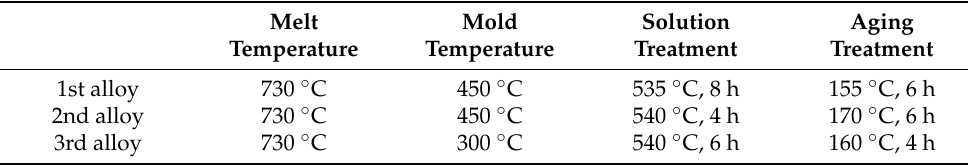
Table 2. Heat treatment conditions for each alloy.